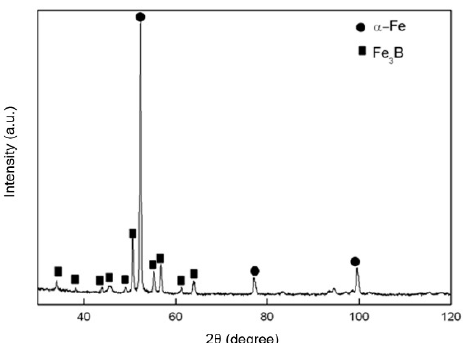
5 of 13 Figure 1. ( a ) X-ray diffraction pattern (Co-K α radiation), ( b ) TEM bright field image and ( c ) the corresponding selected area electron diffraction pattern (SAEDP) of the amorphous as-prepared Fe 85 B 15 alloy. The XRD and TEM investigations were carried out at room temperature. 4.2. Crystallization Product The sample annealed with a heating rate of 5 K min − 1 in the DSC equipment was